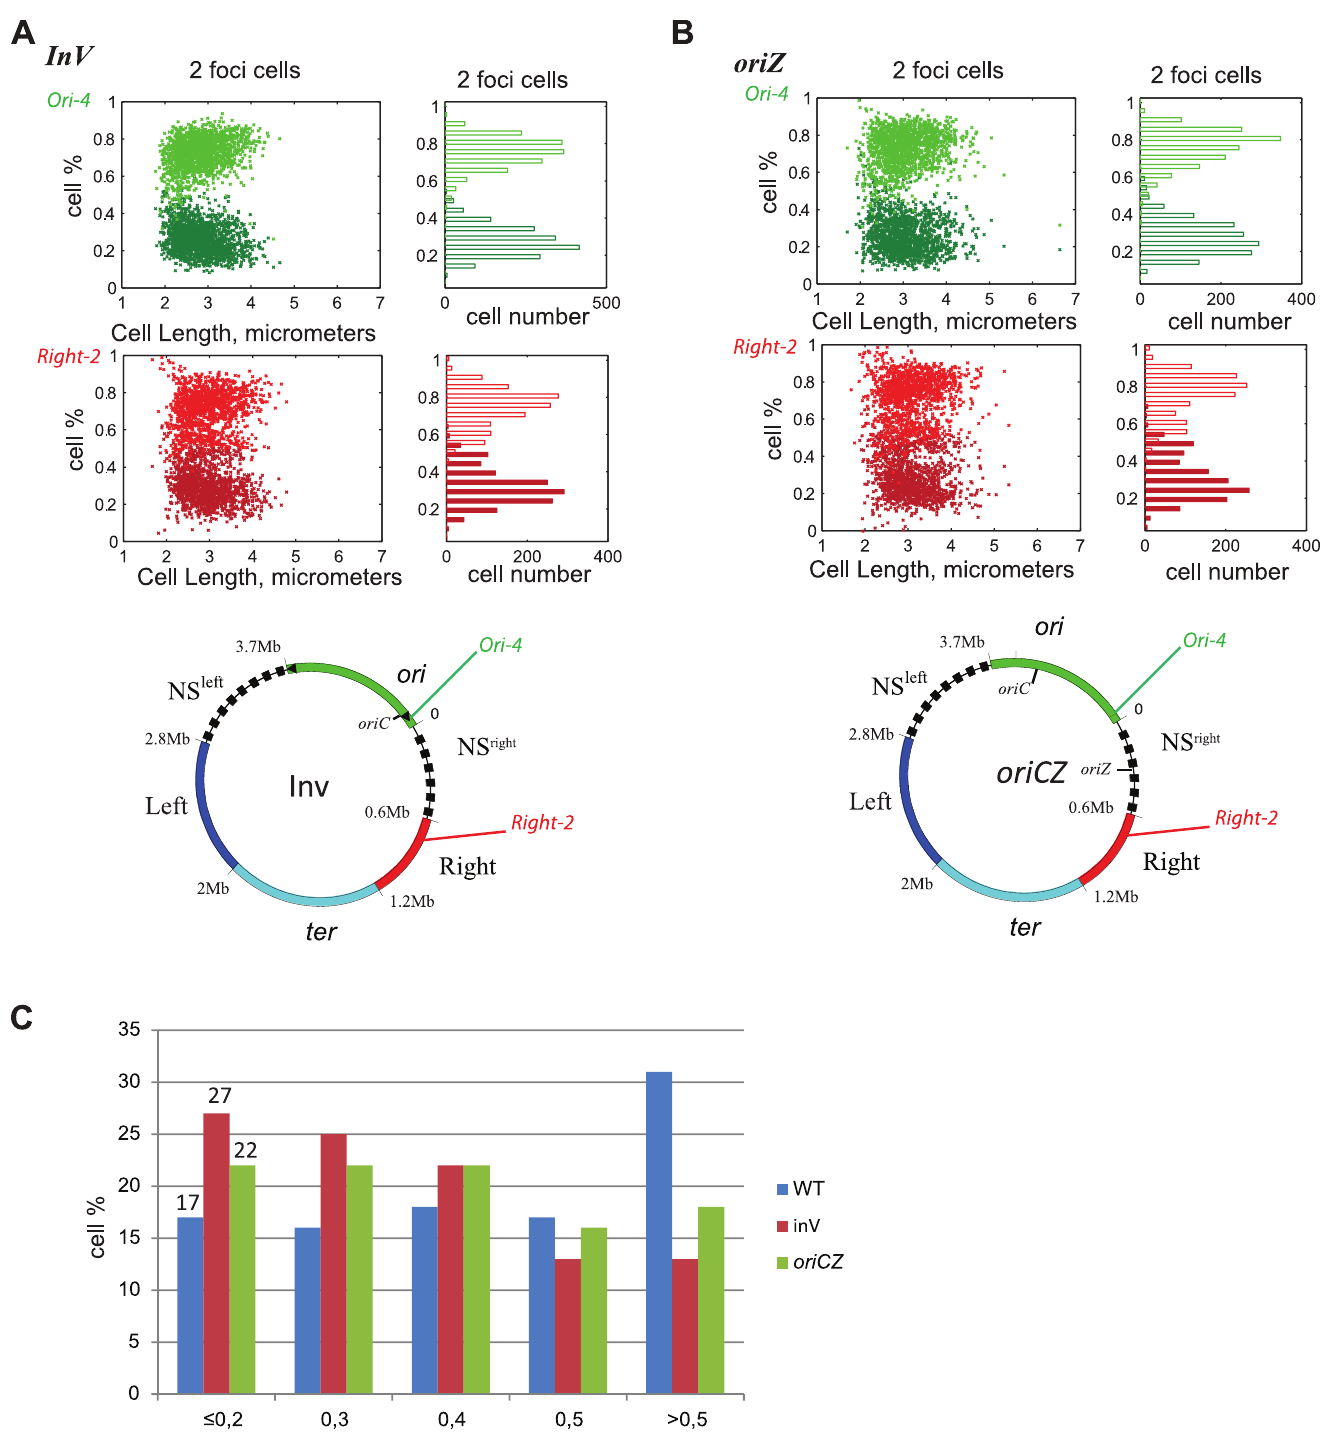
Fig 6. Position of chromosomal loci in the Ori and Right MD depending of oriC position. MD map of the E . coli chromosomeare represented with the positionof the Ori-4, Right-2, FROS-Tag in an Inv (A), or oriCZ (B) configurations. For each panel, the positionof foci in cell containing2 foci (cell with one focus are show in S4 Fig), are represent in function of the long axis of the cell (y-axis) and in function of the cell length(x-axis). Red dots and bars correspond to the localization of the Right-2loci and green ones to the Ori-4 loci. (C) Histogram of the percentageof the populationpresentingdifferent interfocal distance( < 0.2 to > 0.5) betweenOri-4 and Right-2in the WT strain (blue), Inv strain (red) and oriCZ strain (green). Numbers on the first columns show the percentageof cells where both foci are co-localized. https://doi.org/10.1371/journal.pgen.1006758.g006 PLOS Genetics | https://doi.org/10.1371/journal.pgen.1006758 May 9,